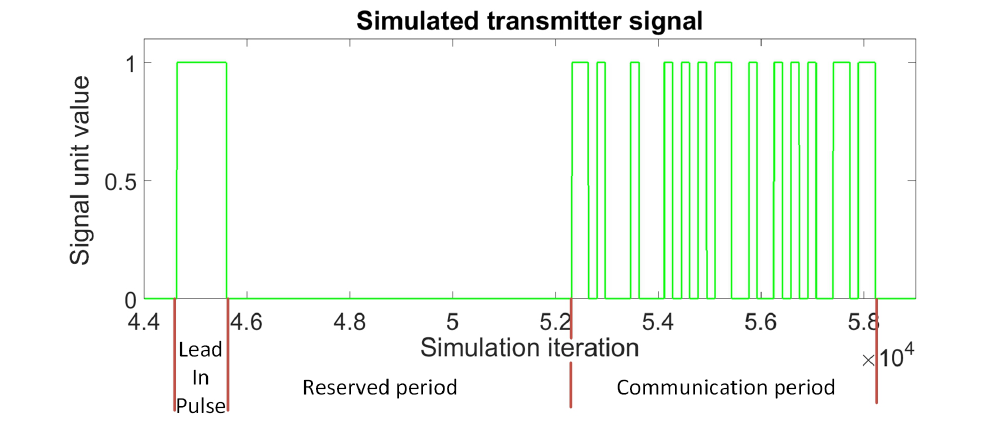
Figure 5. Simulated transmitter